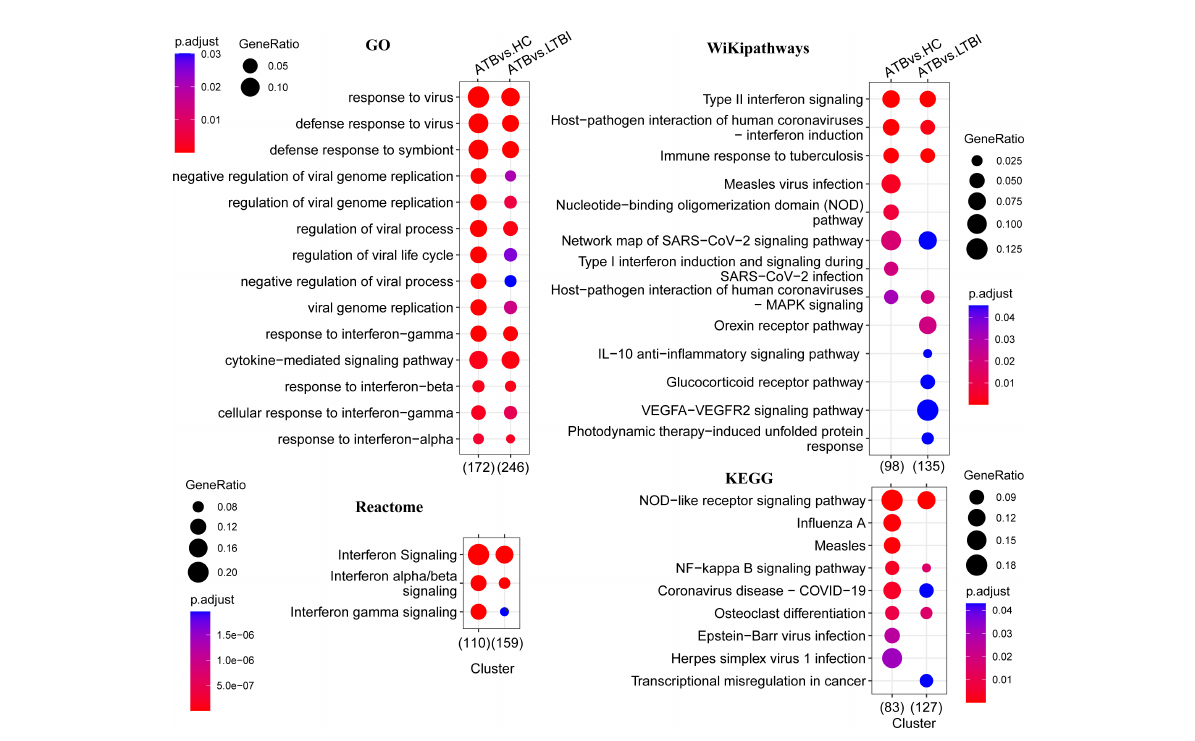
FIGURE 2 Functional enrichment analysis of differentially expressed genes. This fi gure shows the pathways that are signi fi cantly enriched in the differentially expressed genes (p < 0.05), and the GO enrichment analysis only shows the top 15. The color of the bubbles indicates signi fi cance (adjusted P-value), and the size corresponds to the proportion of genes with corresponding